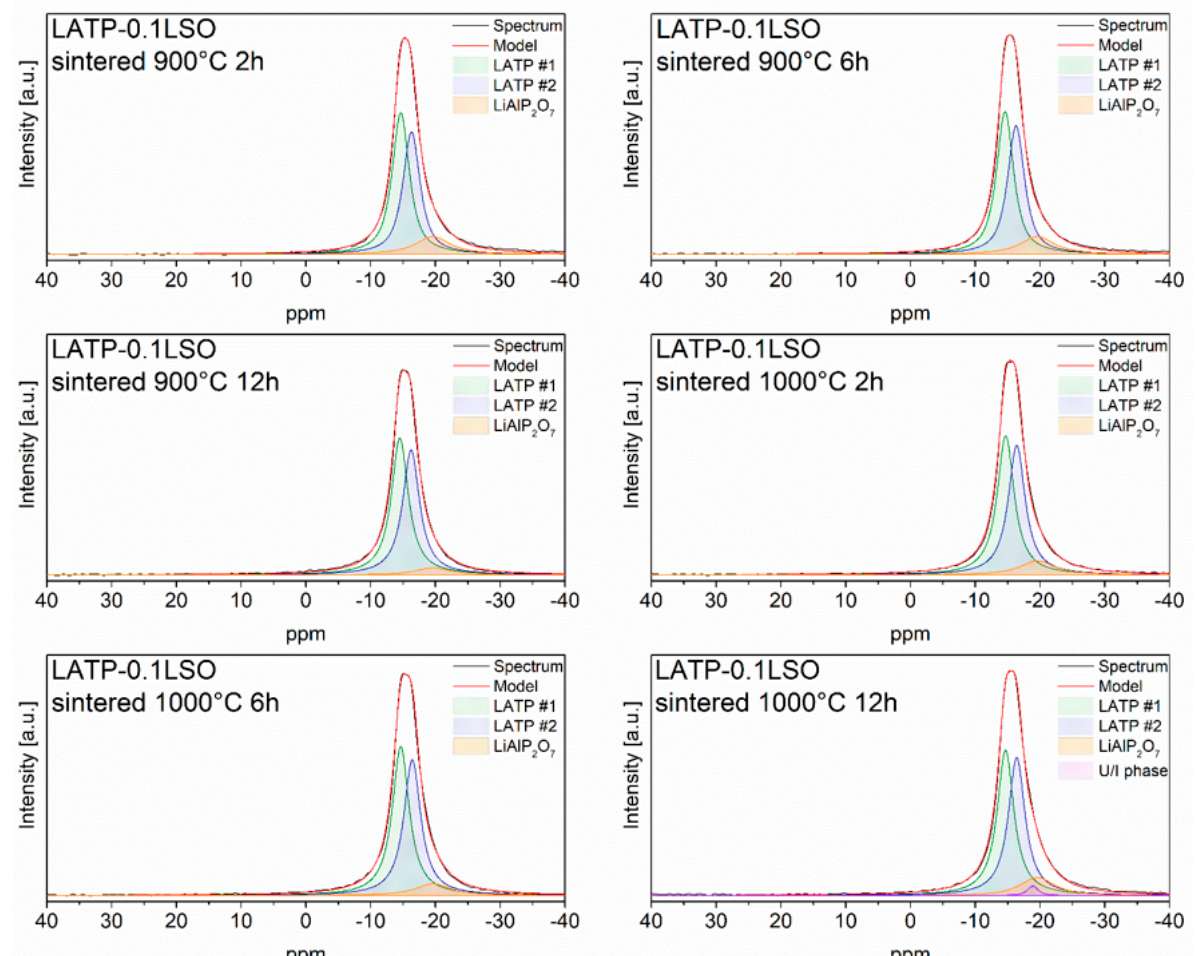
Figure 4. 27 Al MAS NMR spectra of LATP–0.1LSO sintered at 900 and 1000 °C for 2, 6, or 12 h. The experimental and simulated spectra are displayed as black and red lines, respectively. The simulated spectra are the sum of distinct line-shapes displayed as green, purple, and orange lines. 31 P MAS NMR spectra (Figure 5) of sintered LATP–0.1LSO ceramics mainly consist of a highly asymmetric peak located near − 27 ppm. It may be deconvoluted into nine over- lapping lines, located at: − 28.1, − 27.7, − 27.1, − 26.4, − 25.7, − 25.2, − 24.5, − 23.9, and − 23.0 ppm. The signal at − 23.0 ppm could be a tt ributed to the LiAlP 2 O 7 phase [24,42,43], as also de- tected in 27 Al MAS NMR spectra. The previous resonances could be divided in two groups. The fi rst one (LATP #1) contains lines at − 28.1, − 27.1, − 25.7, and − 24.5 ppm, while the other one (LATP #2) includes the signals located at − 27.7, − 26.4, − 25.2, and − 23.9. Both groups are assigned to a phosphorus environment P(OTi) 4 − n (OAl) n (where n = 0, 1, 2, and 3) of the LATP phases with slightly different compositions [24,42]. Besides the discussed signals, three additional resonances at − 10.2, − 6.4, and − 4.1 ppm were also detected. They can be assigned to the lithium-ion conductors, namely the LiTiPO 5 and Li 4 P 2 O 7 (triclinic) phases [24,41–43,49]. It is worth noting that the formation of the LiTiPO 5 phase was also confirmed by XRD investigations. Considering the spectra of materials sintered at different temperatures and times, all seem to be very similar. However, more closer analyses show changes in the integrated intensity of the P(OTi) 4 − n (OAl) n coordinations. A comparison of signal integrated intensi- ties is presented in Table S2. The signal at − 28.1 ppm (LATP #1) or − 27.7 ppm (LATP #2), assigned to the phosphorus P(OTi) 4 environment, decreased, while the one ascribed to P(OTi) 3 (OAl) 1 increased. Further changes were observed for the LATP #1 phase, where